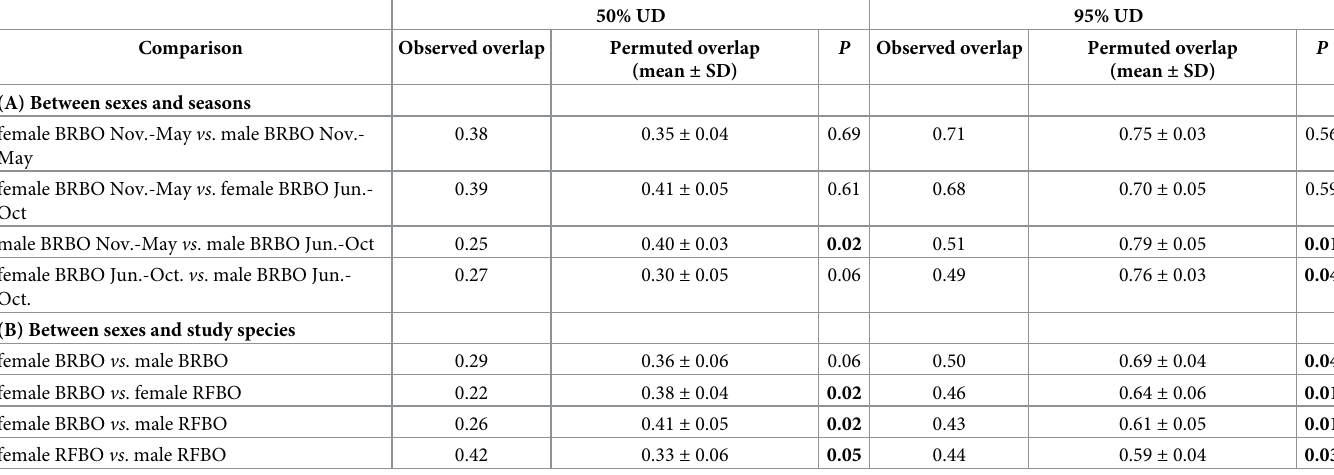
Table 4. Observed and randomized overlap (Bhattacharyya’s Affinity) at the 50% and 95% Kernel utilization distributions (UDs) between (A) female and male brown boobies during November–May and June–October and (B) female and male brown (BRBO) and red-footed boobies (RFBO) during